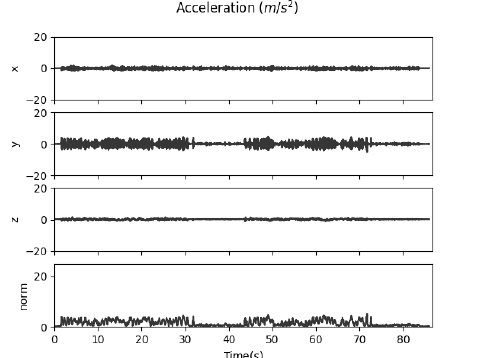
Figure 8. Vibration level of module (Creep, 30cm)